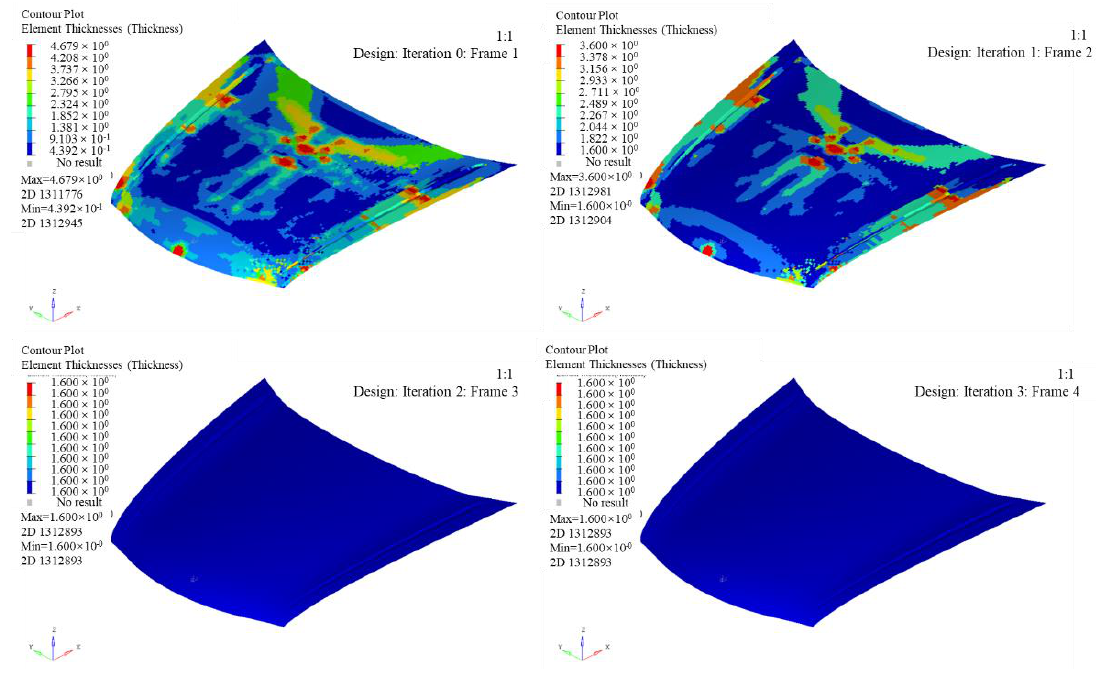
Figure 9. Contour map of outer plate thickness after thickness optimization.